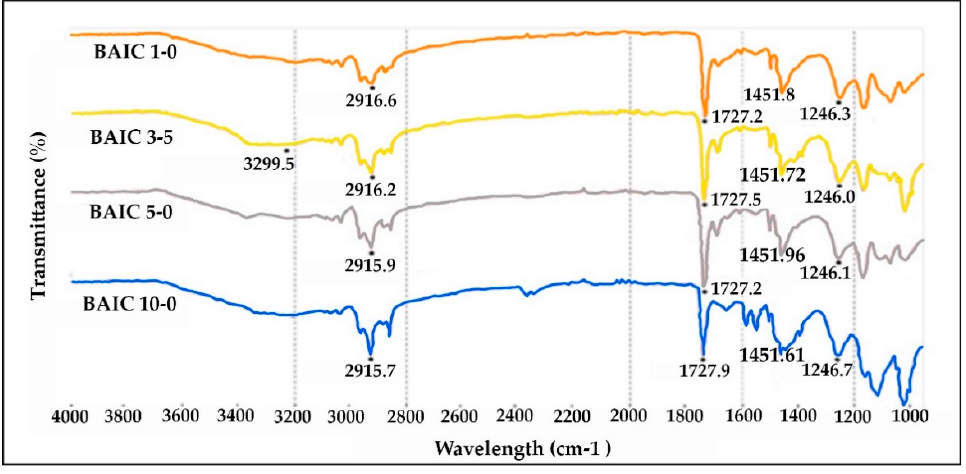
Figure 10. Infrared spectra of BAIC samples.